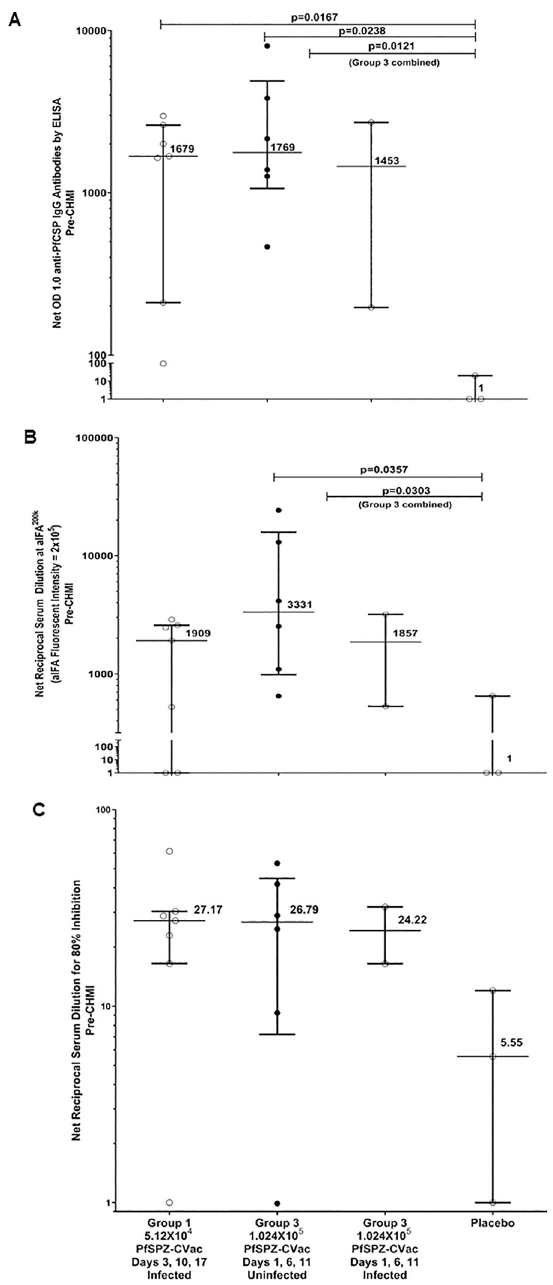
Fig 5. Pre-CHMI antibody comparisons between vaccination and placebo groups. ( A ) Antibodies to PfCSP (net OD 1.0) prior to CHMI. Filled circles are uninfected (protected) subjects and open circles are infected subjects. ( B ) Antibodies to PfSPZ (net aIFA 200K ) measure prior to CHMI. The y-axis refers to aIFA fluorescence intensity of 2x10 5 . Filled circles are uninfected (protected) subjects and open circles are infected subjects. ( C ) Net reciprocal serum dilution for 80% inhibition of PfSPZ invasion of hepatocytes (HC-04 cells) prior to CHMI. Filled circles are uninfected (protected) subjects and open circles are infected subjects. Horizontal lines represent medians and bars are interquartile ranges for all panels. p values for Wilcoxon-Mann-Whitney tests are shown in A-B.